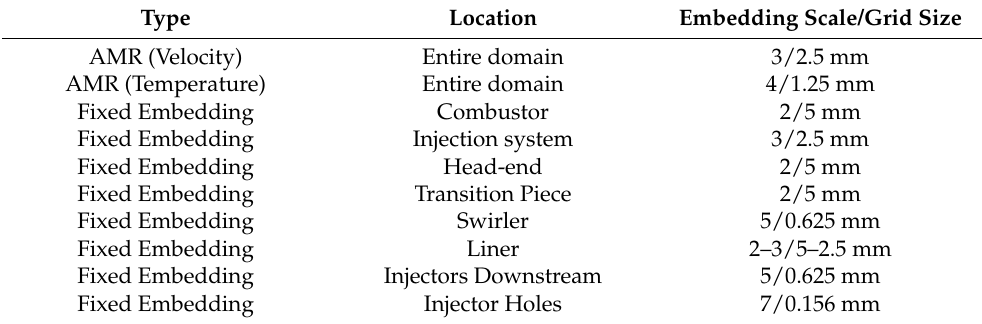
Table 4. Grid control